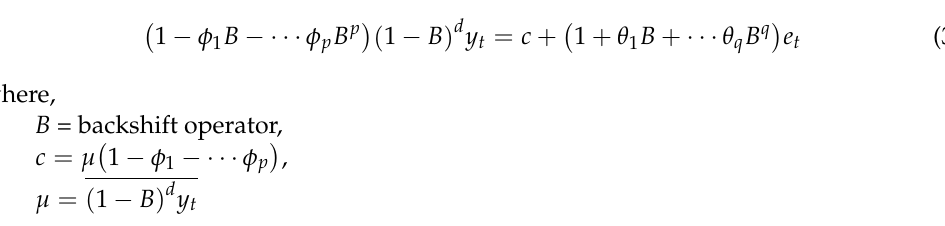
Table 2. Autoregressive integrated moving average (ARIMA) (1, 0, 0) Coefficients. φ µ ARIMA (1, 0, 0) 0.7932 84,508 Standard Error 0.1547